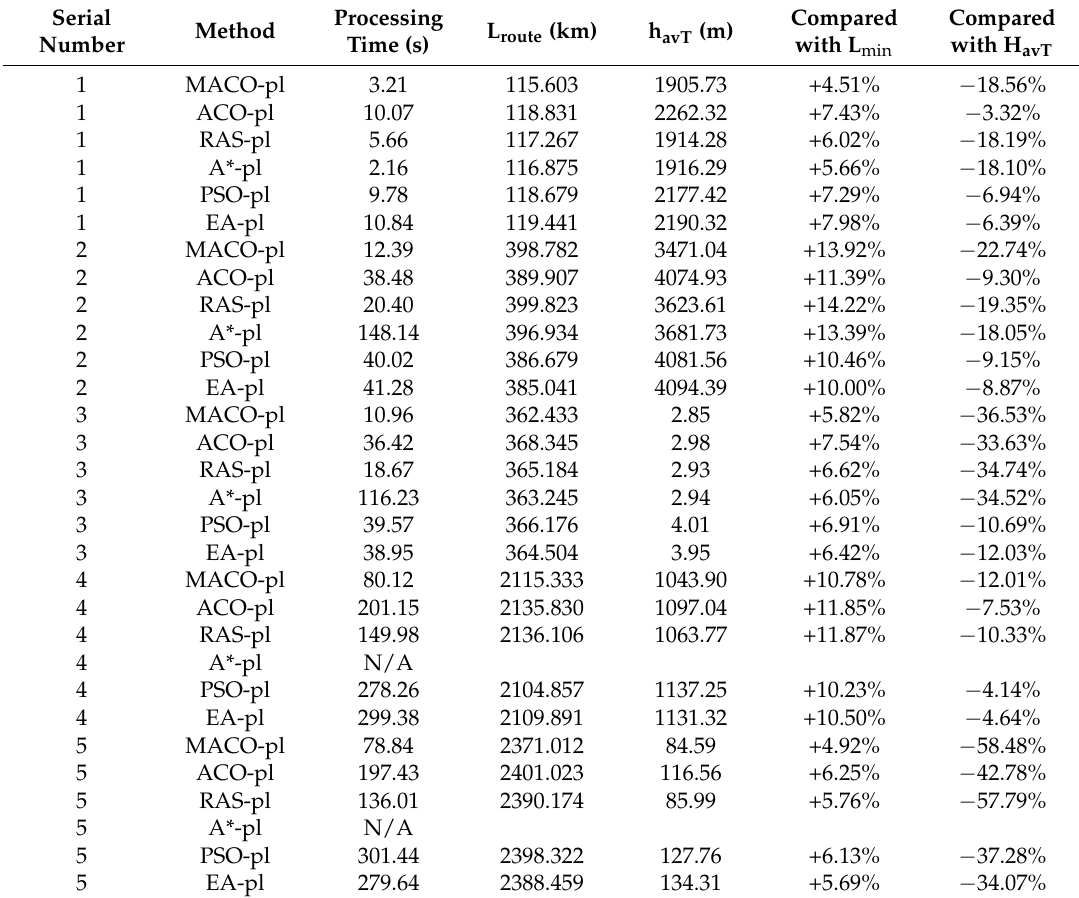
Table 6. Planning results of 1–5 coordinate groups.